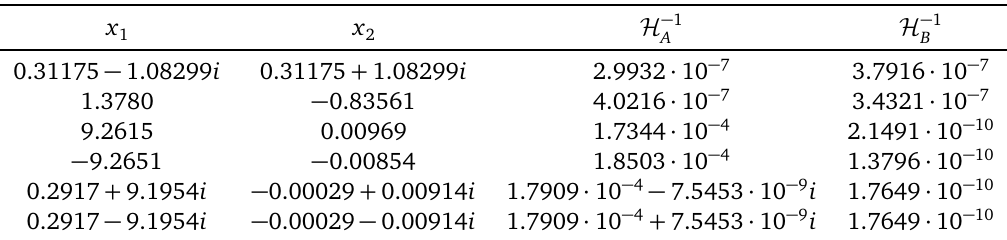
Table 8: Bethe roots and value of the A / B-twisted handle-glue operator for the U ( 2 ) SQCD theory (6.21) with 4